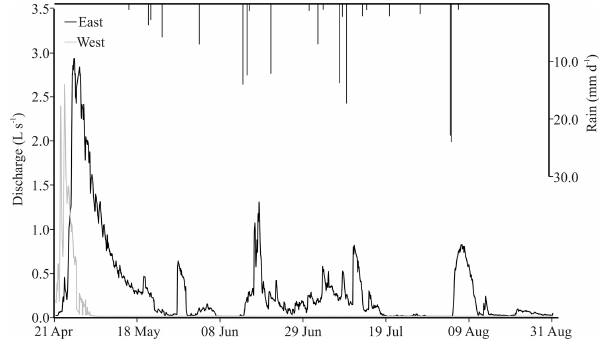
Figure 10. Hydrographs for two adjacent series of wetland cascades (east and west) during the summer of 2014. The plateau-to-wetland ratio of the east cascade is 4 times higher than that of the west cas- cade, explaining the differences in runoff magnitude between the two cascades. Adapted from Connon et al.